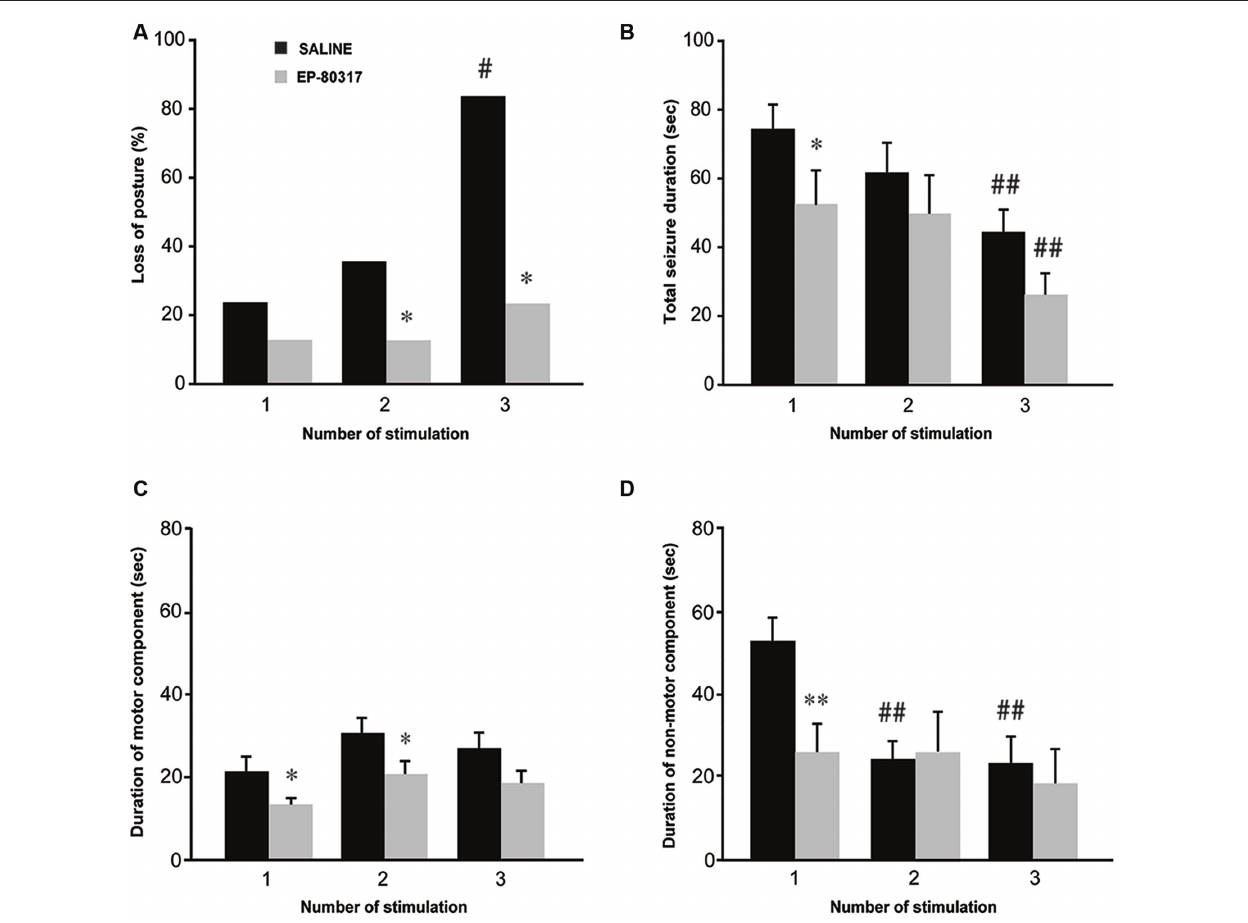
FIGURE 1 | Behavioral response to repeated 6-Hz corneal stimulation in mice treated with saline or EP-80317. Seizures were evaluated for severity and duration. Severity was measured as the percentage of mice developing generalized tonic-clonic seizures associated with loss of posture (A) . Note that loss of posture occurred in a progressively higher percentage of saline-treated mice ( # P < 0.05 vs. session 1 in the same treatment group, Fisher’s exact test; ∗ P < 0.05 vs. saline-treated mice in sessions 2 and 3). The seizure duration (B–D) was evaluated separately for convulsions ( C , motor component) and stunned posture ( D , non-motor component), or as overall duration ( B , including both components). Note that the overall duration decreased progressively after each session in both groups ( ## P < 0.01, session 3 vs. 1; Fisher’s least significant difference (LSD) test). Interestingly, a significantly lower overall duration was initially found in mice treated with EP-80317 ( ∗ P < 0.05 vs. saline-treated mice in session 1; Fisher’s LSD test). When considering only the motor component (C) , this was reduced by EP-80317 in the first two sessions ( ∗ P < 0.05). Concerning the non-motor component (D) , a significant decrease was found in saline-treated mice ( ## P < 0.01, session 2 and 3 vs. session 1). In mice treated with EP-80317 group, the non-motor component did not change in the various sessions and it was initially shorter than in saline-treated mice ( ∗∗ P < 0.01, session